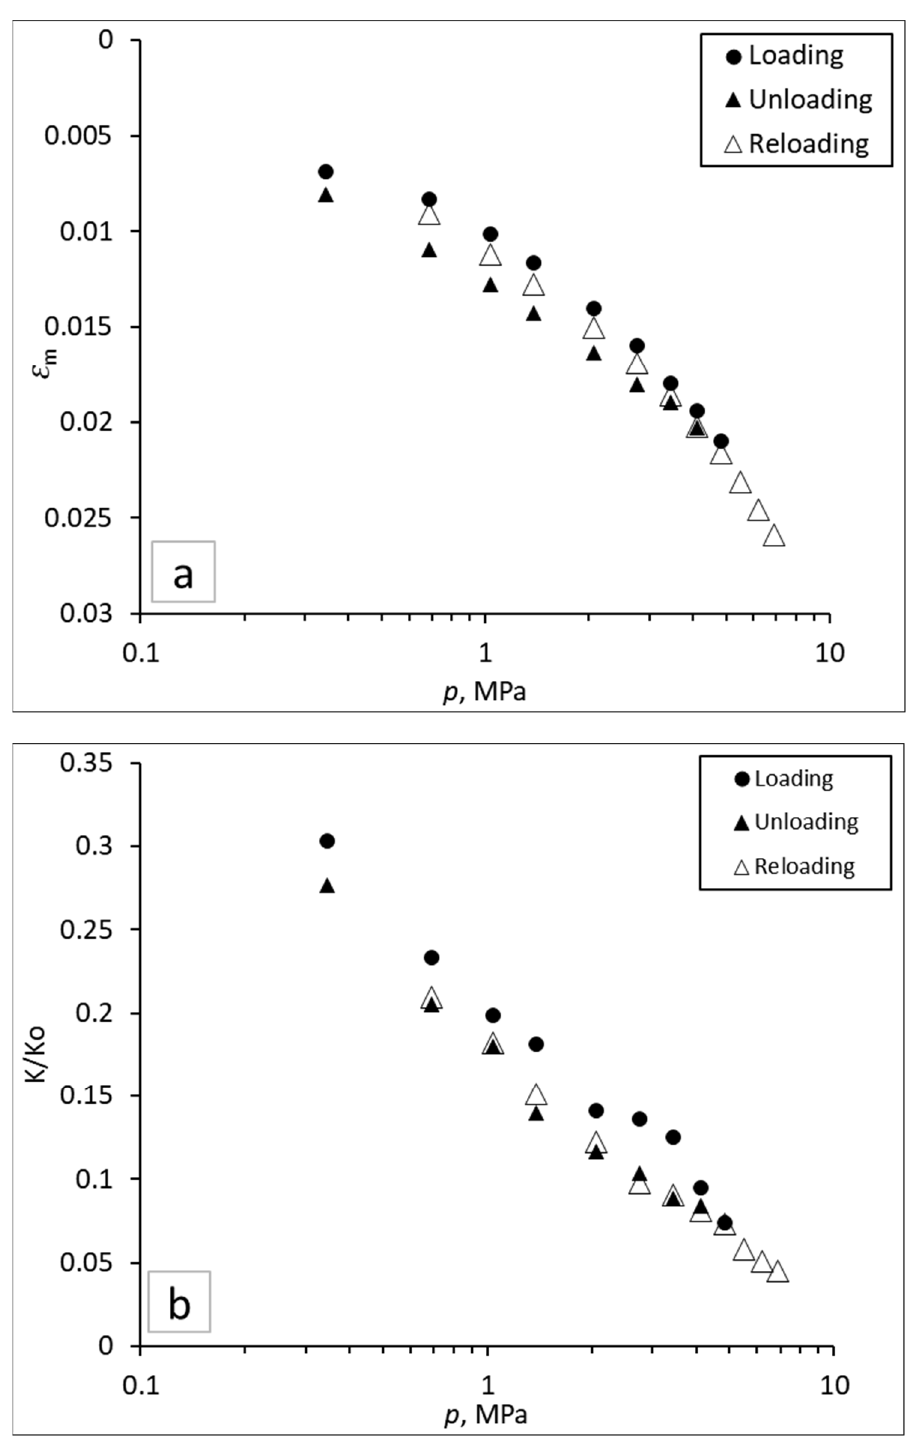
Figure 11. Strain and permeability hysteresis during stress loading–unloading–reloading (up to 6.9 MPa in test 4).